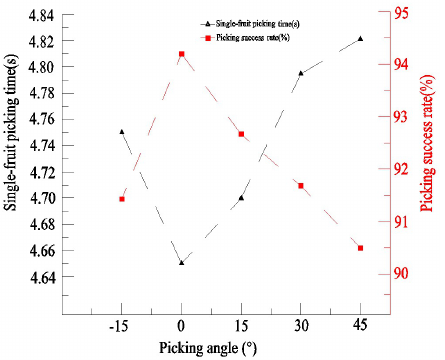
Figure 15. The effect of different picking angles on picking performance.